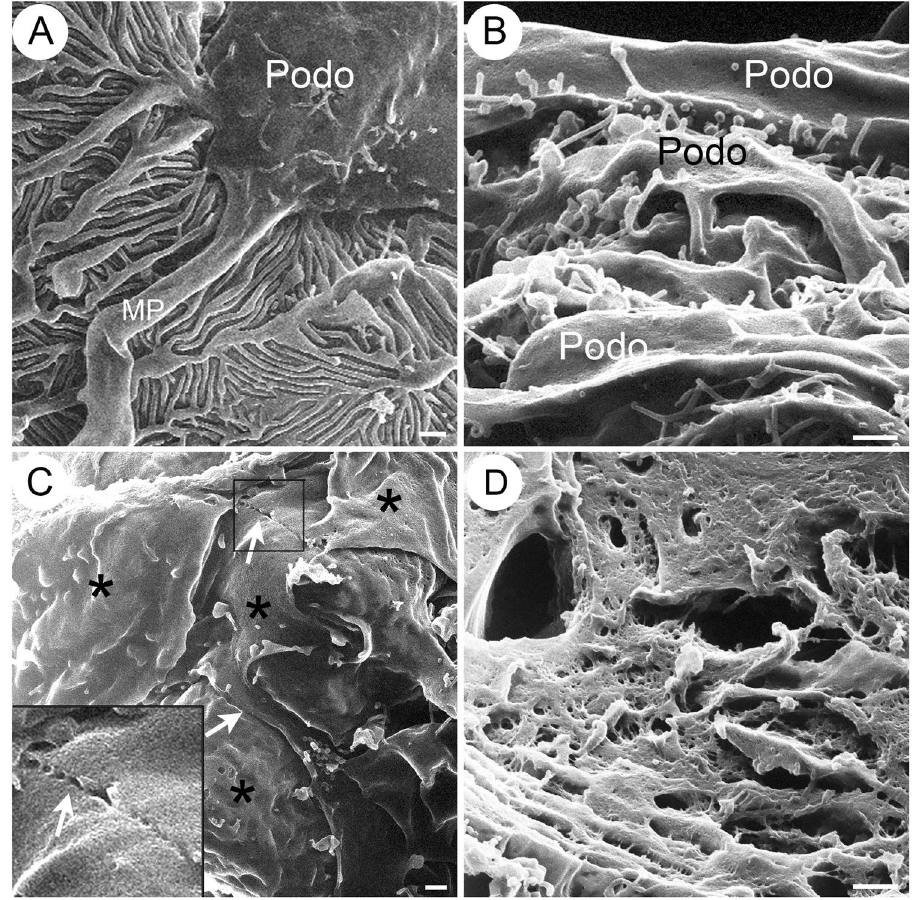
Figure 3. Podocyte ultrastructure at late stage in CD2AP deficient mice compared with WT mice. HIM images of podocytes in WT ( A ) and late stage Cd2ap -KO ( B – D ) mice are shown. ( A ) WT podocytes appear normal, with interdigitated structures formed by major processes and foot processes. Podocytes at late stage show broadly fused and flattened podocyte processes ( B , C ), and form irregular, flat sheets loosely covering the underlying structure ( C , asterisk). Intercellular junctions (white arrows) are seen between some of these sheets ( C ). Terminally sclerosed glomeruli show uninterpretable glomerular ultrastructure ( D ). Some structures appear to be remnants of endothelial fenestrae or filtration slit pores that lost underlying membrane support. Scale bars, 500 μ m. P, podocyte; MP, major process. Podo, podocyte; MP, major